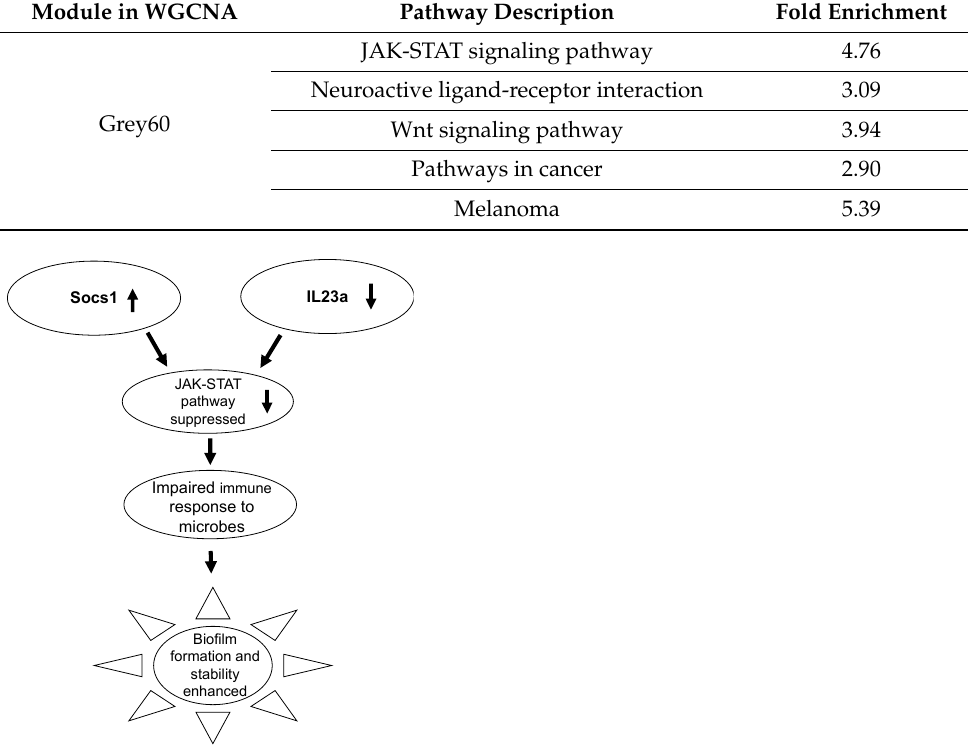
Figure 6. Implications of inhibition of JAK–STAT Pathway in full chronicity. Socs1 is a negative regulator of the JAK–STAT pathway; therefore, its overexpression downregulates JAK–STAT, as is shown by the underexpression of STAT genes. As an additional level of downregulation, Il23a is also underexpressed in chronic wounds. The IL23 heterodimeric cytokine complex which forms when IL23a binds to IL23r activates STAT3. Phosphorylated STAT3 then dimerizes and translocates to the nucleus where it turns on gene expression associated with adaptive and innate immunity. This leads to the stimulation of type 17 helper T (Th17) cells, which are crucial for host defense response against invading microbes and fungi. Downregulation of Il23a shows that JAK–STAT is downregulated, and therefore, stimulation of Th17 is downregulated as well, which could contribute to microbes persisting in chronic wounds leading to biofilm